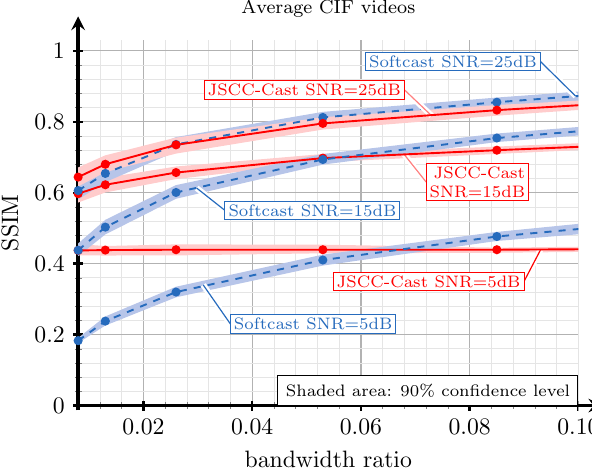
Figure 13. SSIM versus bandwidth ratio for a selection of videos with CIF resolution extracted from [39]. The SSIM values were obtained with the proposed JSCC-Cast video system and Softcast for different channel qualities. The red lines correspond to the proposed JSCC-Cast, and the blue lines correspond to